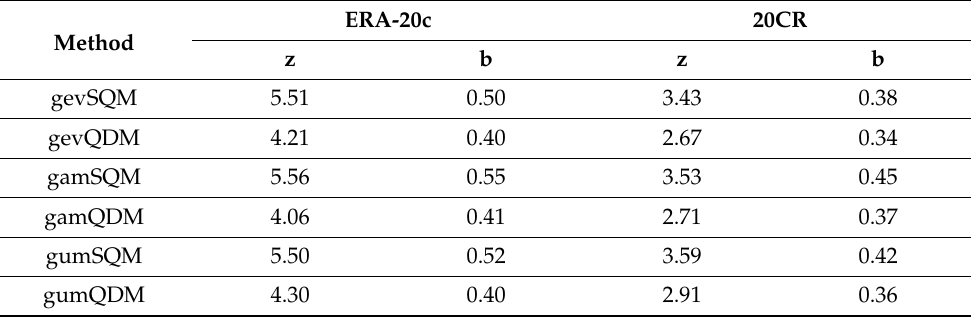
Figure 9. Inter-annual change of the AMRs of the bias corrected ERA-20c and 20CR by QM approaches (( a ) gevSQM, ( b ) gevQDM, ( c ) gamSQM, ( d ) gamQDM, ( e ) gumSQM, and ( f ) gumQDM]. The bold blue line and bold red line represent the means of the ERA-20c AMRs and the 20CR AMRs over 48 stations, respectively, while the light blue and red lines indicate the movements of individual AMRs for ERA-20c and 20CR, respectively. The straight lines represent the linear fit to AMRs from 1900 to 2010. Table 4. Mann–Kendall test results for the mean of the AMRs of the bias corrected ERA-20c and 20CR by QM approaches from 1900 to 2010 as illustrated in Figure 9. Note that z and b (mm/year) values represent the standardized test statistics and the slope of the trend, respectively, and z values over 1.96 indicate a significant trend at the 0.05 significance level in this